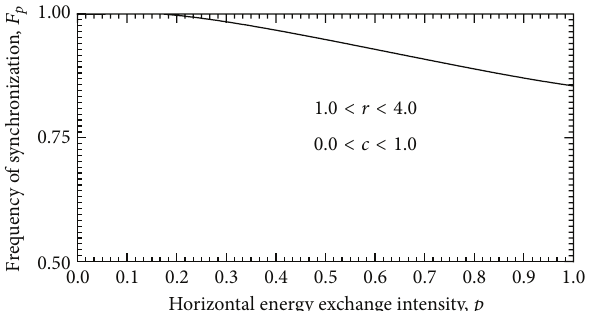
Figure 4: Normalized frequency of synchronization, 𝐹 𝑝 (𝜆 < 0) , for system of environmental interfaces passively coupled (12)–(14) as a function of parameter of exchange 𝑝 . An averaging was done over all values of coupling parameter 𝑐 and logistic parameter 𝑟 .